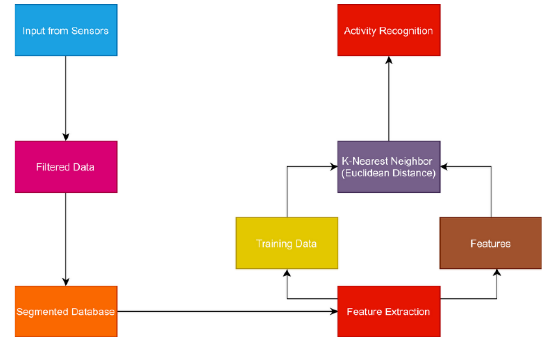
Figure 7. Histogram plot for the counts of occurring against each activity (Walking, Sitting, and Standing, Lying, Downstairs and Upstairs)